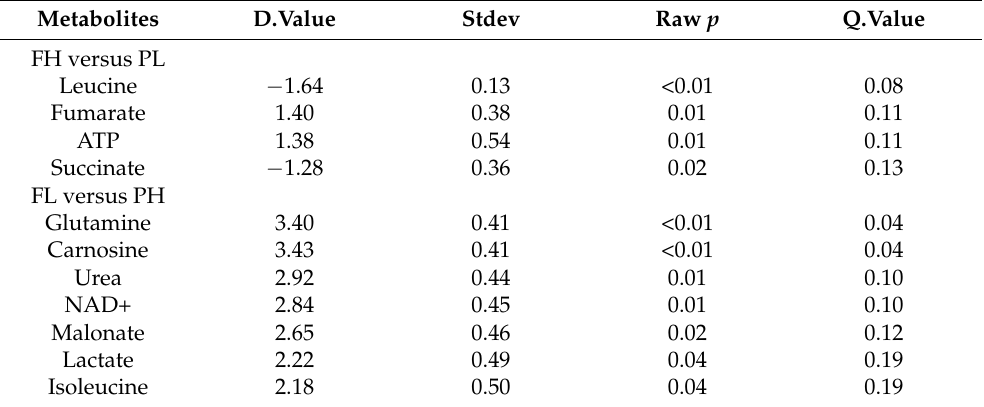
Succinate − 1.28 FL versus PH